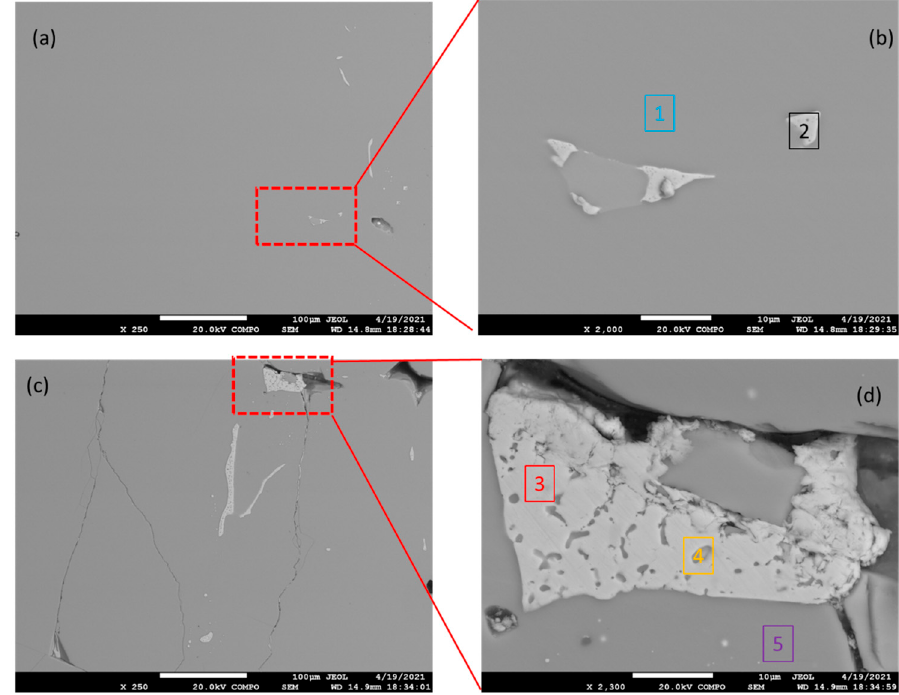
Figure 1. BSEM images of the as-cast microstructure of the Mg 2 Sn alloy. The edge of the sample is shown in ( a , b ); center of the sample is shown in ( c , d ). The chemical composition of points 1–5 is given in Table 2. Table 2. Chemical composition of points 1–5 in Figure 1 measured by EDX.